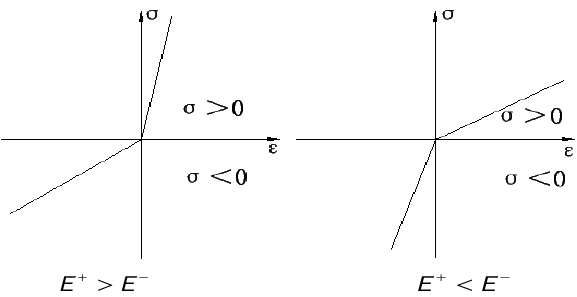
Figure 1. Bimodulus materials model proposed by Ambartsumyan.